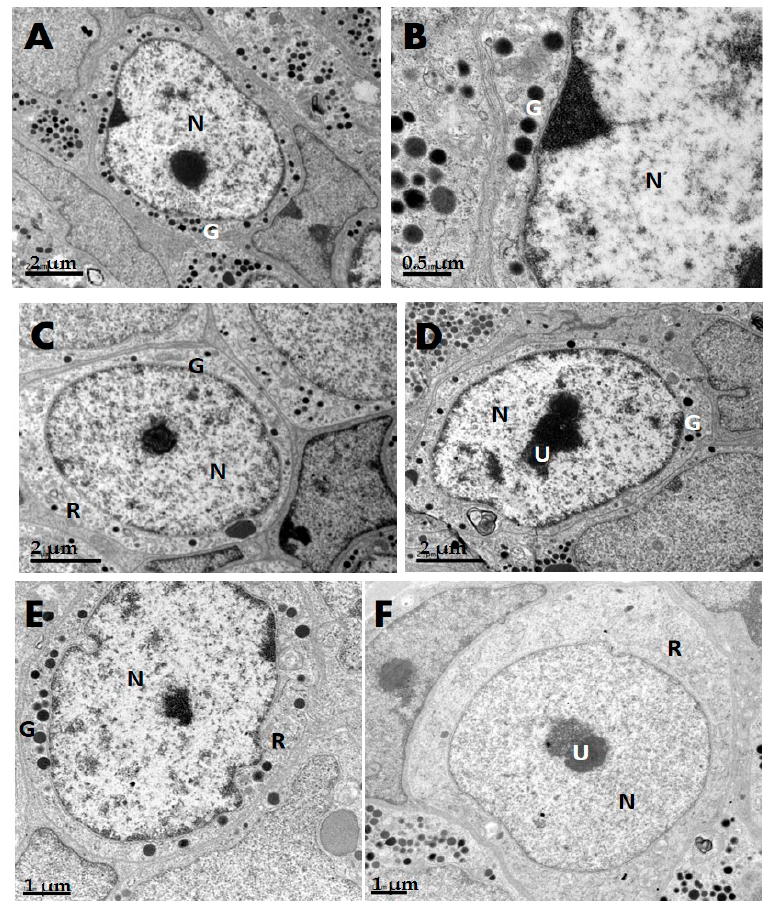
Figure 1. Chinemys reevesii pituitary GH cell ultrastructure in the winter. ( A ) A GH cell showing a few secretory granules and a big nucleus; ( B ) An enlarged section of ( A ) showing secretory granules in the cytoplasm; ( C ) appearance of the rough endoplasmic reticulum and ribosomes in GH cells; ( D ) nucleoli located in the center of a nucleus; ( E ) a GH cell showing depressed border of nucleus and scarce secretory granules; ( F ) a GH cell with no observable secretory granules. N, Nuclei; G, Secretory granules; R, Rough endoplasmic reticulum; U, Nucleoli.